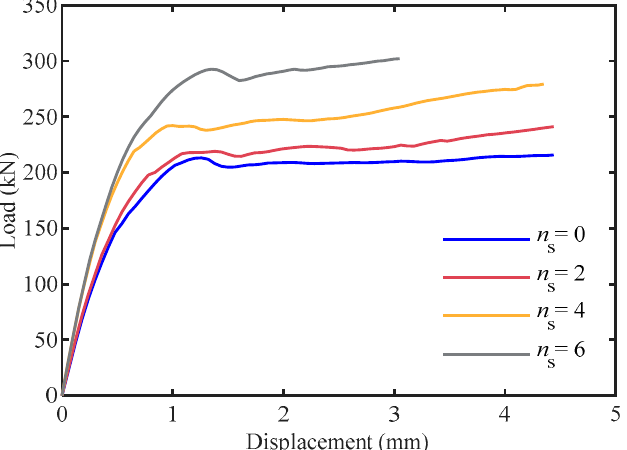
Figure 19. Influence of the number of shear studs.